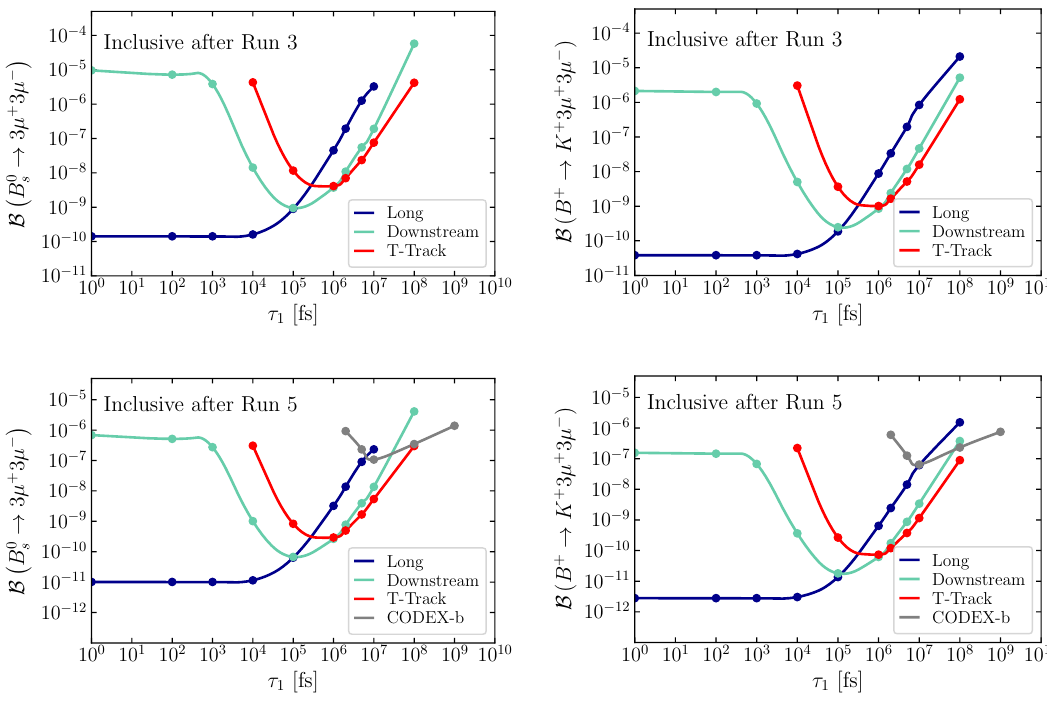
Figure 3 . Same as in figure 2, but requiring only four muons in the final state. Also included are the projected bounds for the CODEX-b experiment, requiring the presence of only one muon pair inside the